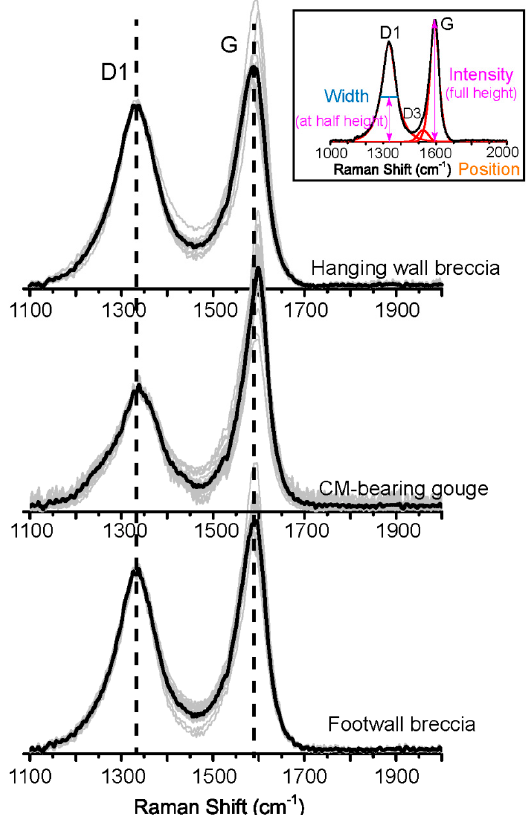
Figure 3. The representative first-order region of Raman spectra from different fault components. The inset shows the usage for defining the indicative parameters derived from the relevant spectrum decomposition (width, intensity, peak position, etc.).